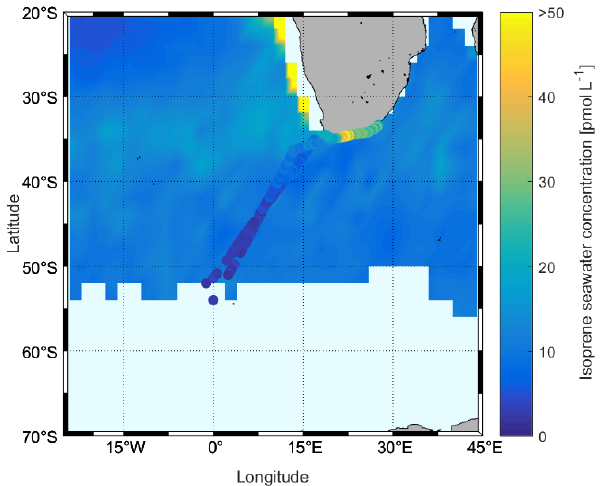
Figure 10. Comparison between measured sea surface isoprene concentrations during the SCALE cruise (cruise track trace) and those computed using a satellite-based model (Booge et al., 2016) for August